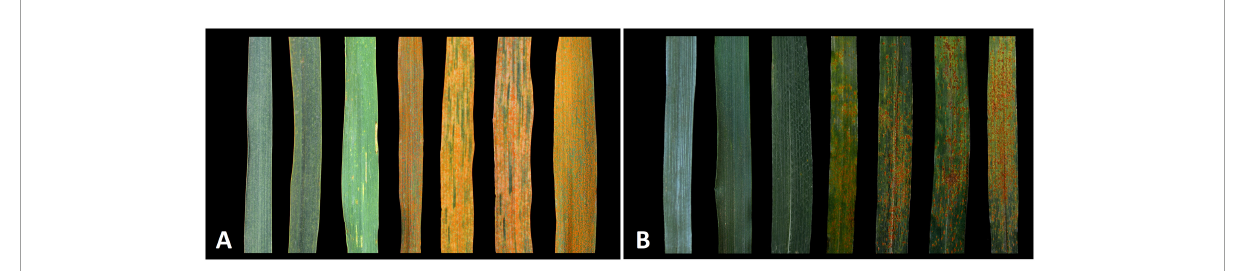
FIGURE3 Stripe rust and leaf rust responses of tested materials at the heading stage. (A) A mixture of stripe rust races CYR32, CYR33, and CYR34 (1:1:1 ratio) were inoculated on (from left to right): Thinopyrum intermedium , TAI8335, CH51, Jinchun 5, Jinmai 33, Jintai 170, Taichung 29. (B) A mixture of leaf rust races TRT, TRJ, and KHJ (1:1:1 ratio) were inoculated on (from left to right): Th. intermedium , TAI8335, CH51, Jinchun 5, Jinmai 33, Jintai 170, Nanda